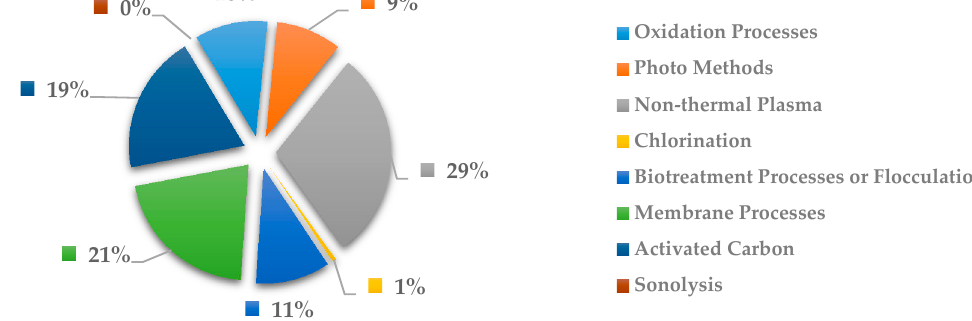
Figure 30. Percentage of scientific articles worldwide regarding wastewater treatments of hematological drugs between 1998 and 2020. Data collected in Scopus database by using wastewater or water as keywords and English as a language limitation. Table 7. Pharmaceutical removal methods in pharmaceutical groups under study in Scopus.